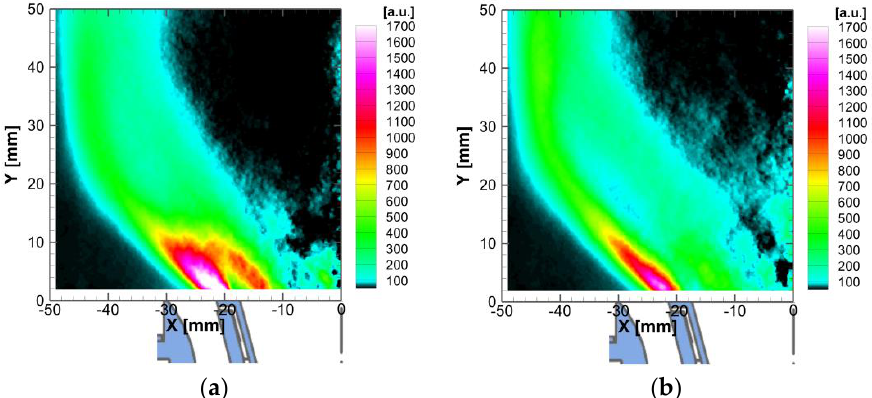
Figure 9. Deconvoluted OH* distribution under idle conditions: ( a ) case P and ( b ) case M. (Illustration of the burner exit section is superimposed beneath the horizontal axis).